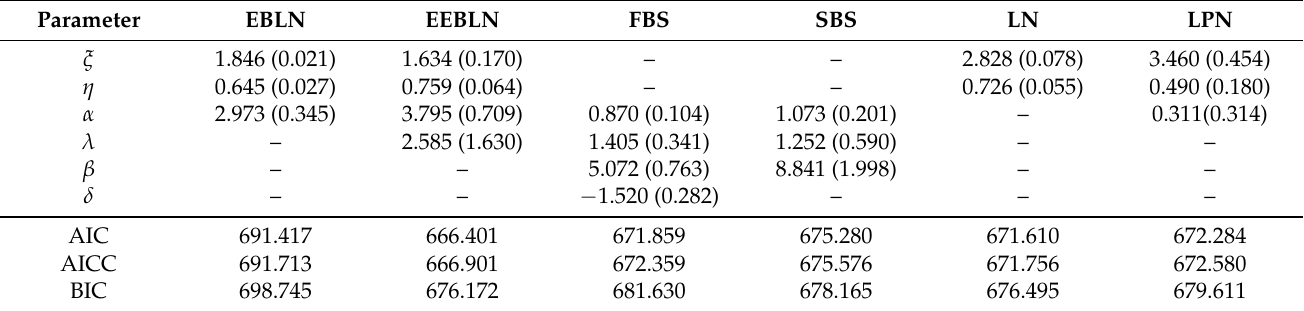
Table 2. Maximum likelihood estimates (standard errors) of the fitted